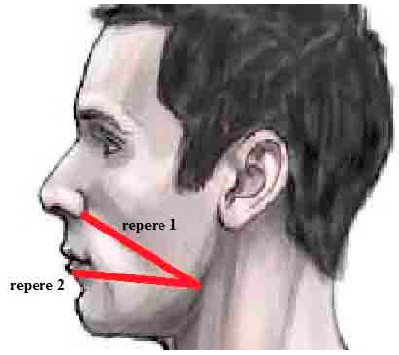
Figure 4. Referrals on the face for the measurement of the swelling. Measurements were performed before surgery (t0) and at three time points after the surgery: 2 days after surgery (t1); 7 days after surgery (t2); 14 days after surgery (t3). Association between variables was evaluated with univariate regression analysis; p - values < 0.05 were considered statistically significant.